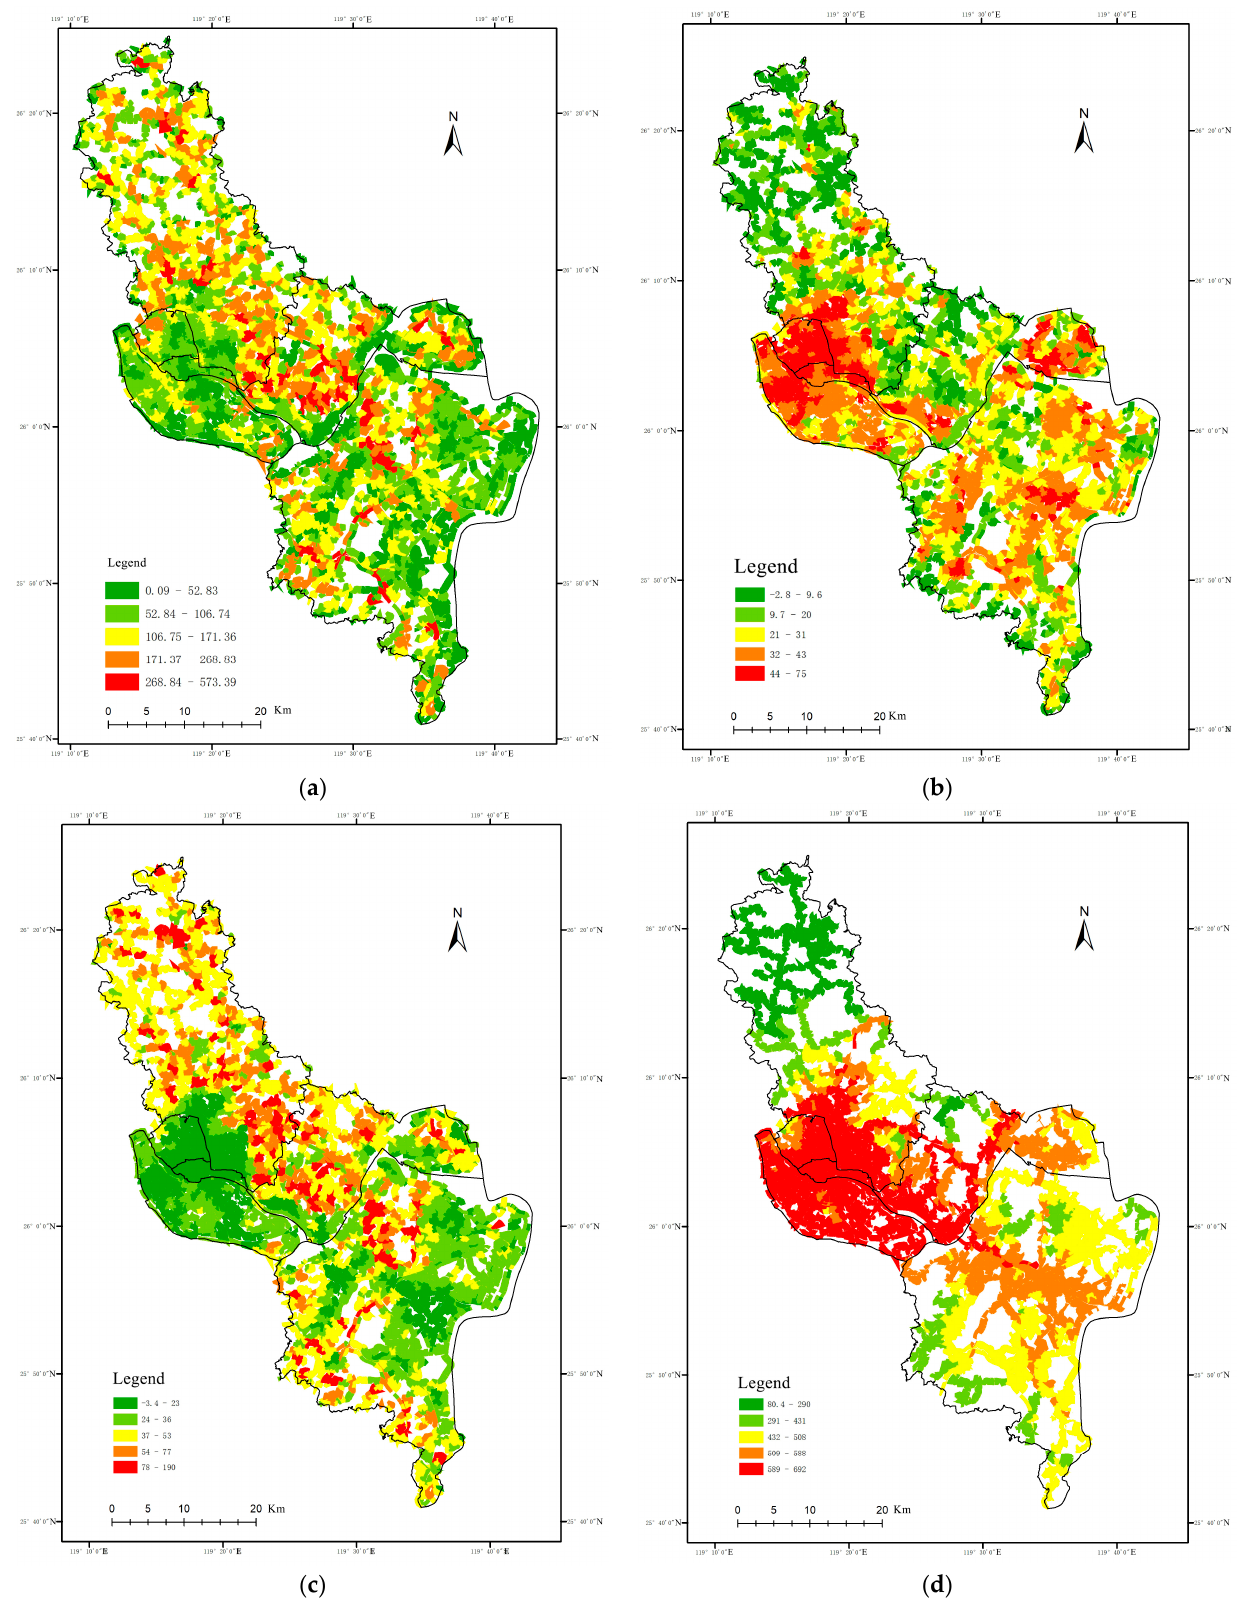
Figure 12. Distribution of green space accessibility factors in urban areas of Fuzhou: ( a ) green space accessibility area; ( b ) green space shape complexity factor; ( c ) green space aggregation factor; and ( d ) road integration.